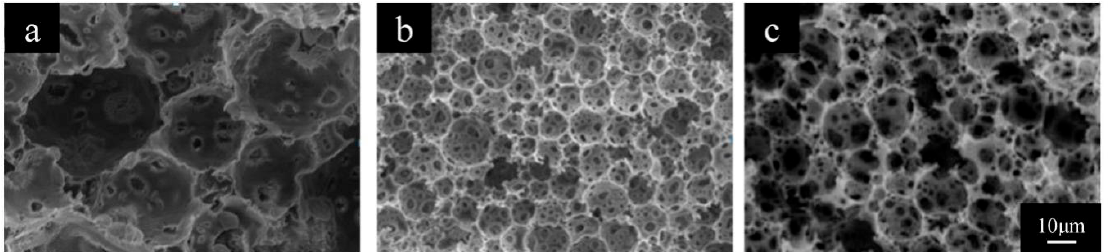
Figure 5. SEM images of PolyHIPE Scaffolds fabricated with emulsifier amount of ( a ) 30%, ( b ) 40% and ( c ) 50%.